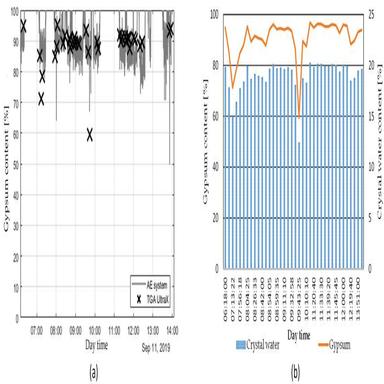
Live prediction of gypsum content (a) with corresponding TGA data (b).